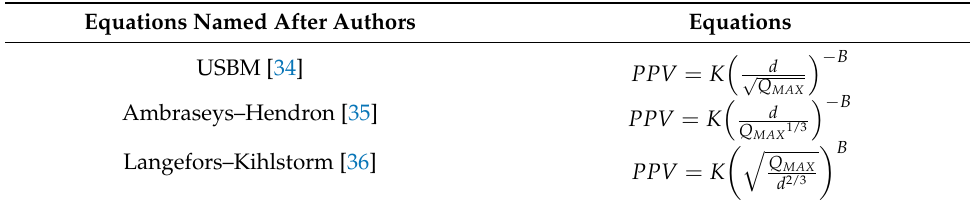
Table 2. Different vibration predictor equations.